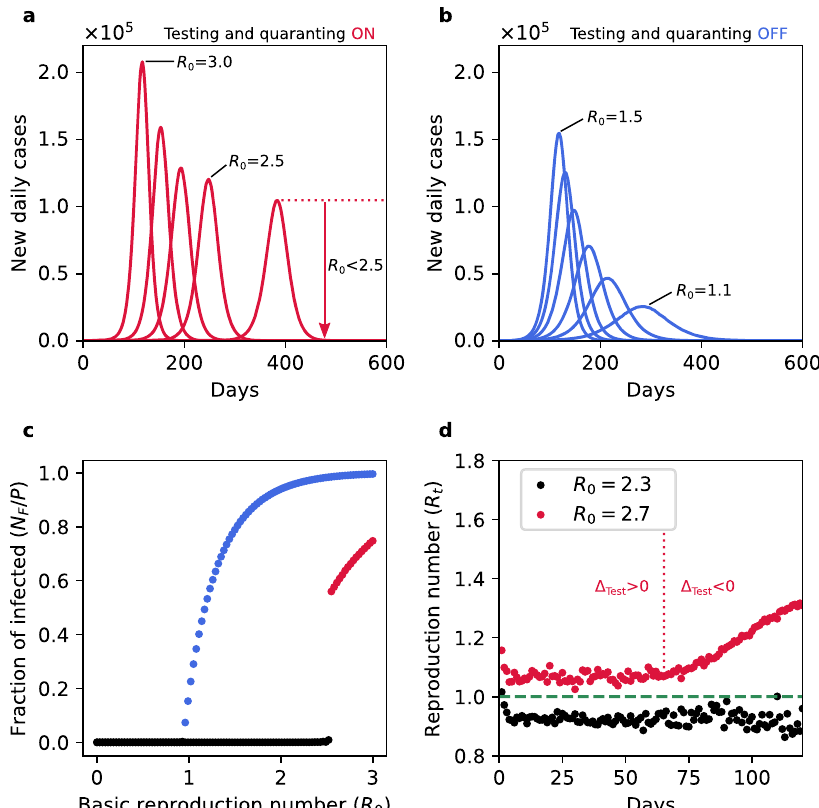
Fig. 2 Discontinuity in fl attening of epidemic curves. a Daily new cases for continuously decreasing values of R 0 (3> R 0 > 0), mimicking mitigation measures of increasing strength. Testing and quarantining are carried out at the same time with a capacity limit of N T = 1000 tested individuals per day. Initially the peak reduces continuously in response to mitigation (red curves from left to right), however, once R 0 is reduced below 2.5 the epidemic curve drops to very small numbers of new cases (curves not visible in the fi gure scale). b Daily new cases for decreasing values of R 0 (1.5 > R 0 > 0) without testing and quarantining. Decreasing progressively R 0 gradually fl attens the epidemic curve (blue curves from left to right) until a very low number of cases is reached (curves not visible in the fi gure scale). c Final fraction of infected ( N F / P ) as a fun c tion of R 0 corresponding to the curves shown in a (red dots) and b (blue dots). The black dots denote outbreaks that have been effectively suppressed. When testing and quarantining are active the epidemic transition becomes discontinuous and happens at a higher basic reproduction number ( R 0 ≈ 2.5) in comparison to the usual continuous epidemic transition observed at R 0 = 1. d Evolution of the reproduction number with testing and quarantining active. Such measures ef fi ciently reduce the reproduction number R t below unity for R 0 < 2.3 (black dots). For larger values of R 0 testing and quarantining can initially reduce the reproduction number to a constant level, however, R t remains above one (red dots). Owing to the continuing spread the number of suspects will eventually exceed the daily test limit and hence Δ Test changes sign (red dashed line in d ). At this point the spread accelerates and R 0 increases. The values of R t have been averaged over 400 and 100 simulations for R = 2.3 and R = 2.7, respectively. In all these cases the population size is P = 3162× 3162 ≈ 10 7 people and epidemics start with 100 initial 0 0